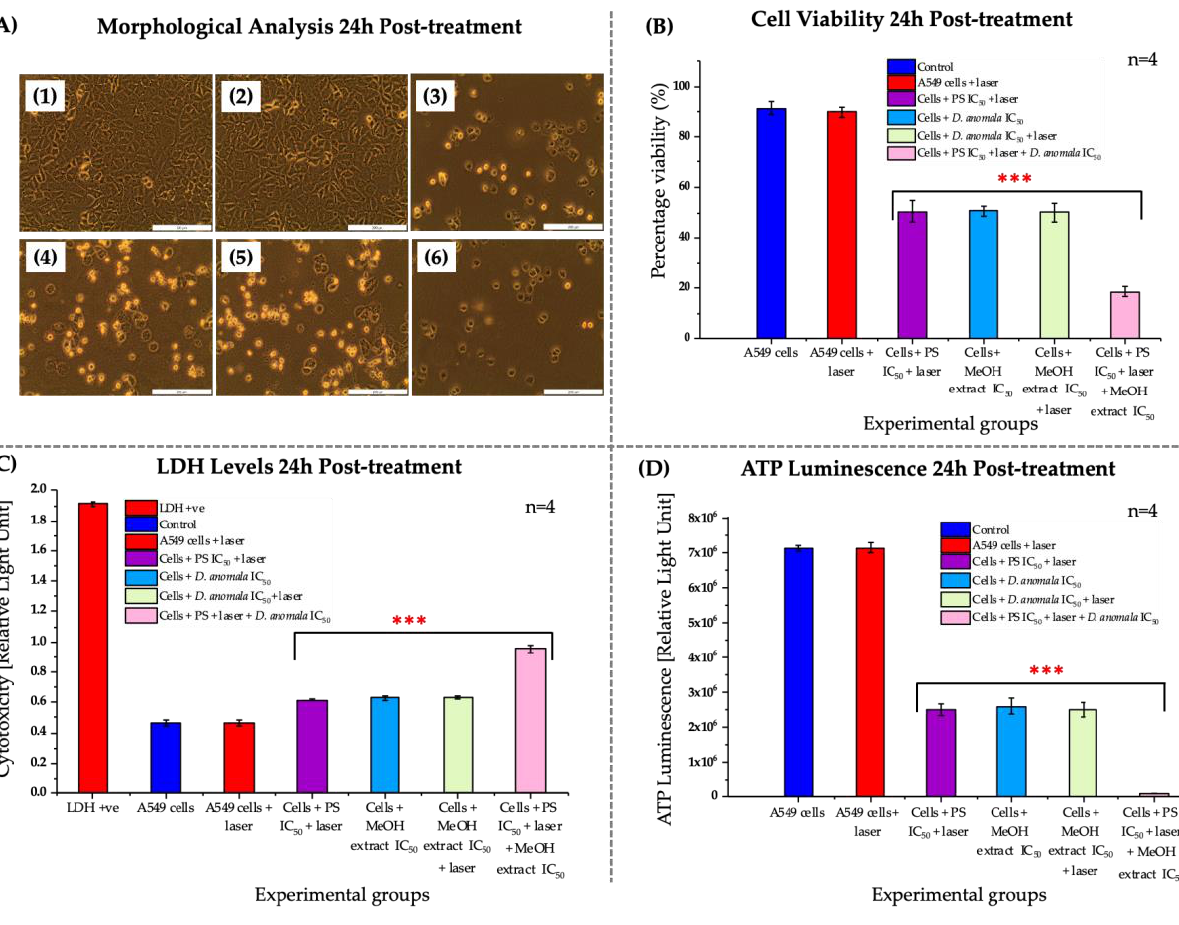
Figure 6. Morphological analysis of A549 cells post-treatment ( A ). Untreated cells ( A1 ), 680 nm laser light treated cells ( A2 ), ZnPcS 4 -mediated PDT IC 50 treated cells ( A3 ), D.A MeOH root extract IC 50 treated cells ( A4 ), D.A MeOH root extract IC 50 + laser irradiation ( A5 ), and D.A MeOH root extract